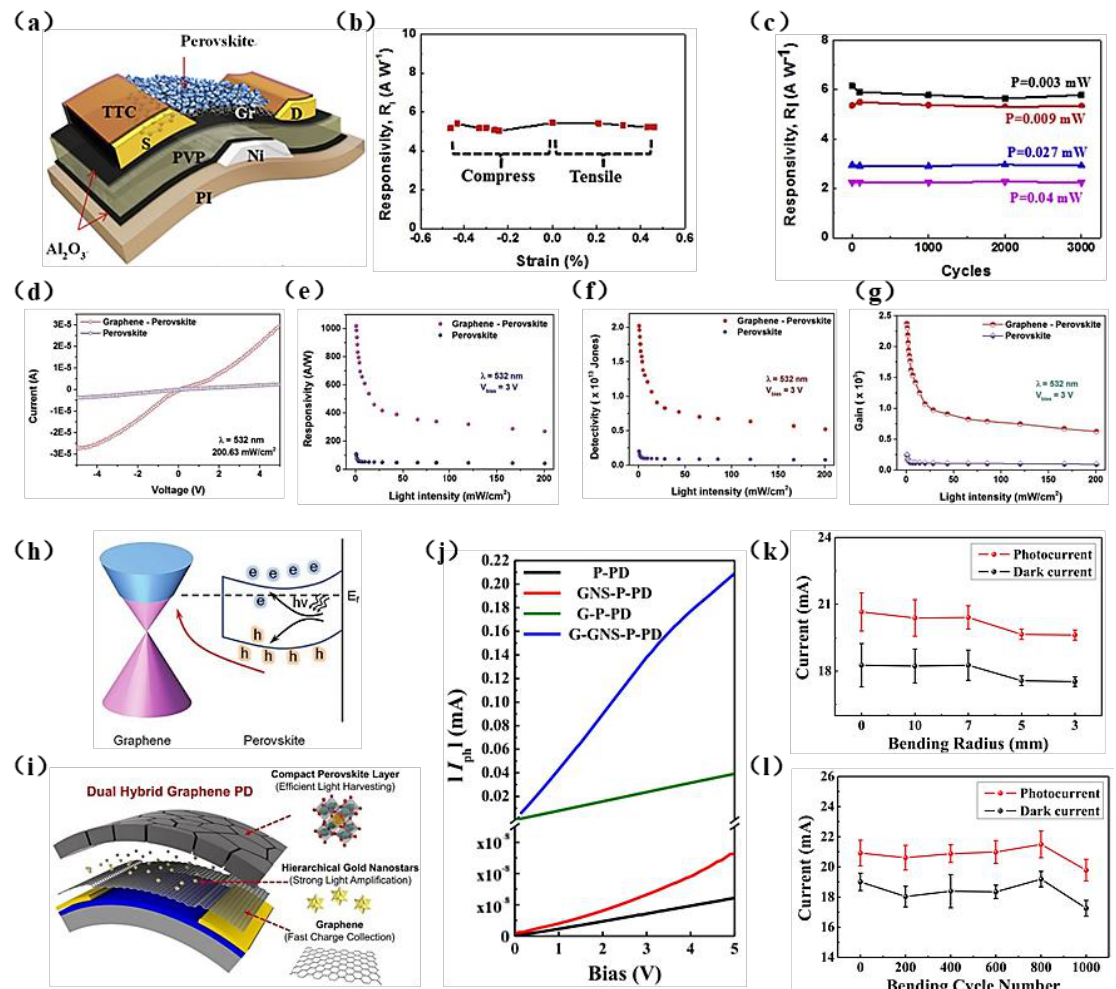
Figure 5. ( a ) Schematic diagram of a cross section of the flexible PD device. ( b ) Photocurrent respon- sivity (RI) of the flexible PD under various strain conditions, from a compressive strain of 0.46% to a tensile strain of 0.4% at a wavelength of 515 nm. ( c ) RI of the flexible PD prior to and after cyclic bending for up to 3000 cycles at a bending radius of 12 mm. Reproduced with permission